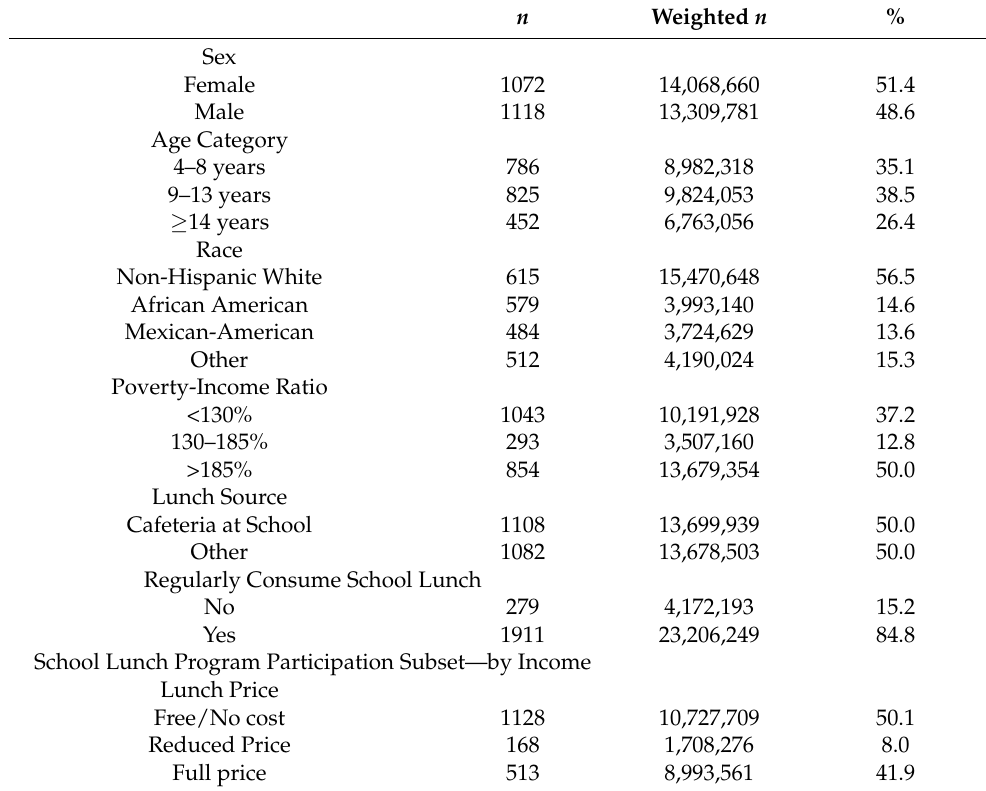
Table 1. Demographic Characteristics of NHANES 2009–2012 Eligible School